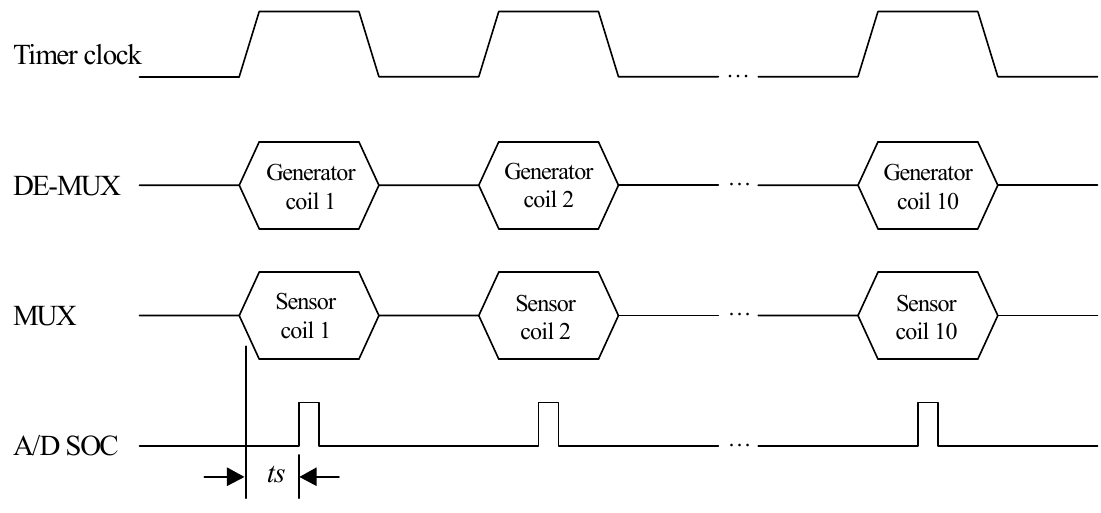
Figure 13. The timing diagram of the data glove control signals.